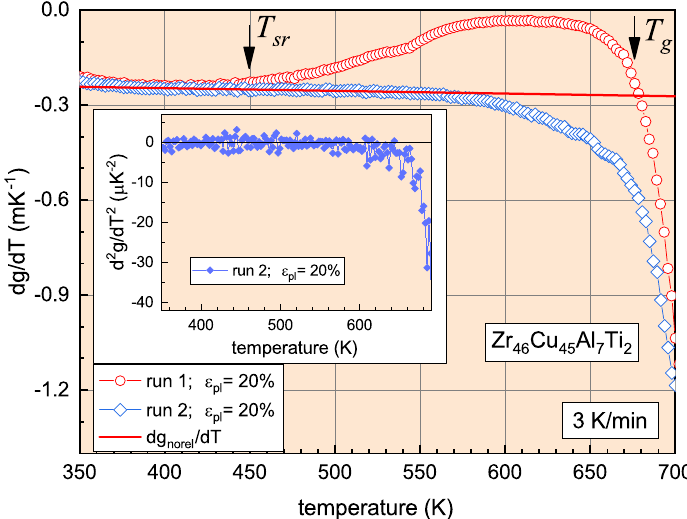
Figure 2. Temperature dependences of the first derivative of the normalized shear modulus over temperature dg / dT in the initial (run 1) and relaxed (run 2) states of a sample predeformed by ε pl = 20%. The derivative of the non-relaxation component is given by the straight line. The inset gives temperature dependence of the second derivative d 2 g / dT 2 in the relaxed (run 2) state. The glass transition temperature T g and the temperature of structural relaxation onset T sr are indicated by the arrows.